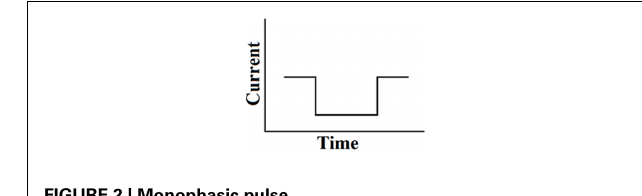
FIGURE 2 | Monophasic